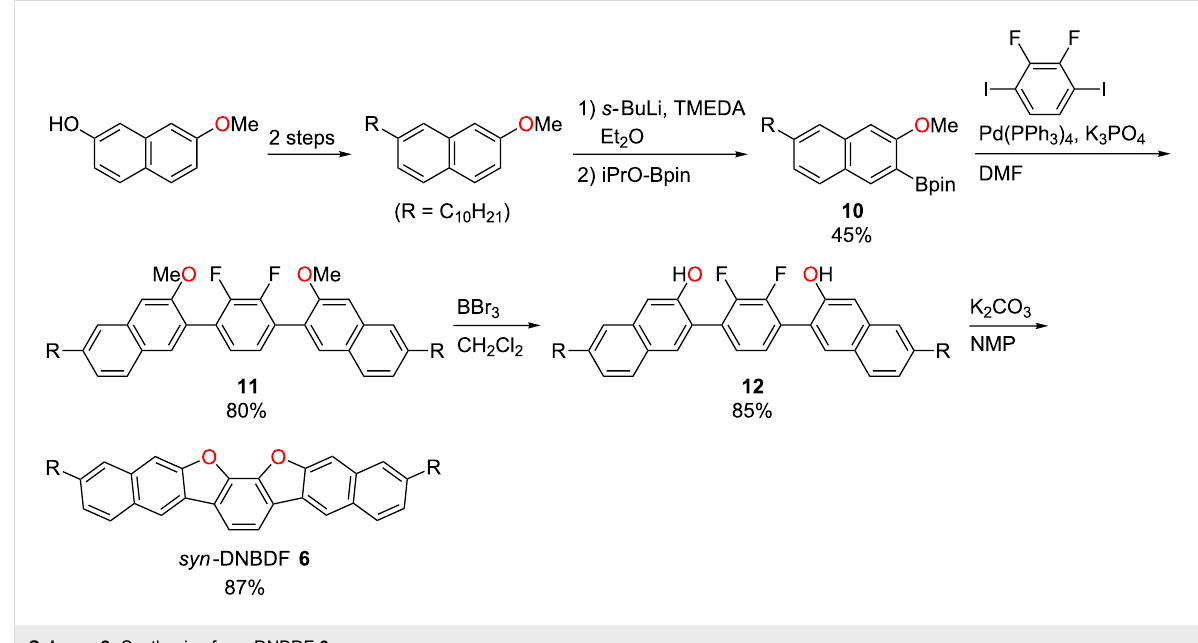
Scheme 2: Synthesis of syn -DNBDF 6 .